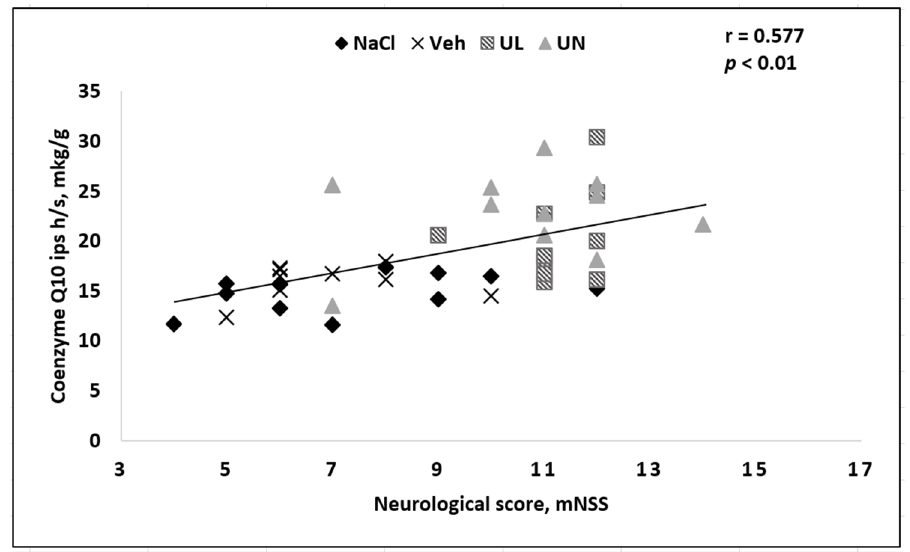
Figure 8. Correlation between the severity of neurological deficit and CoQ10 brain level in the ipsilateral hemisphere in rats after occlusion of the middle cerebral artery. Groups: NaCl–MCAO + NaCL; Veh–MCAO + Vehicle; UL–MCAO + Ubiquinol; UN–MCAO + Ubiquinone.